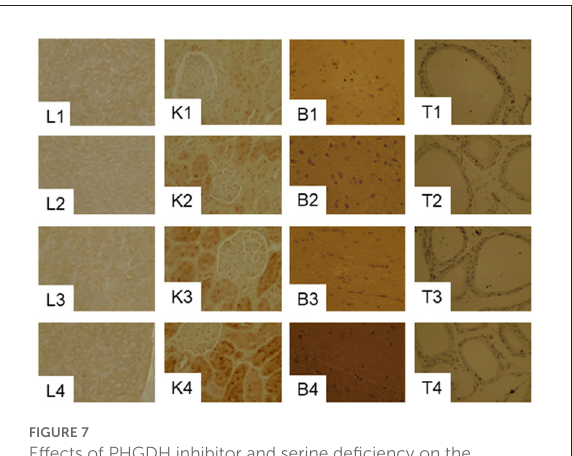
FIGURE7 Effects of PHGDH inhibitor and serine deficiency on the expression of GPx1in the liver (L1–L4), kidney (K1–K4), brain (B1–B4) and Testis (T1–T4) tissues in pregnant rats fed 20% casein (experiment 2). See the legend of Figure 7 for other abbreviations.